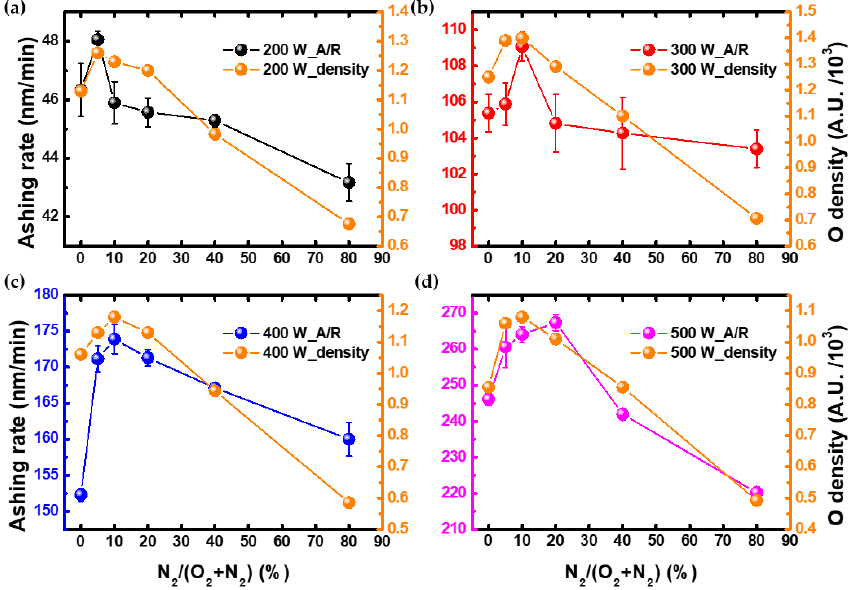
Figure 7. These are the ashing rate and oxygen radical density as N 2 /(O 2 +N 2 ) ratio at ( a ) 200 W, ( b ) 300 W, ( c ) 400 W, and ( d ) 500 W.